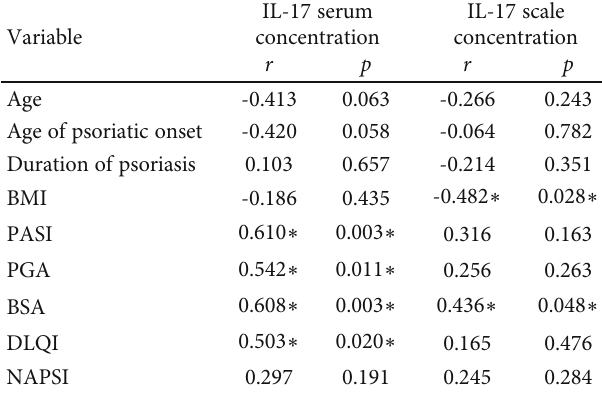
Table 2: The correlation between IL-17 serum, scale concentration and clinical features and disease severity in psoriatic patients; ∗ statistically signi fi cant